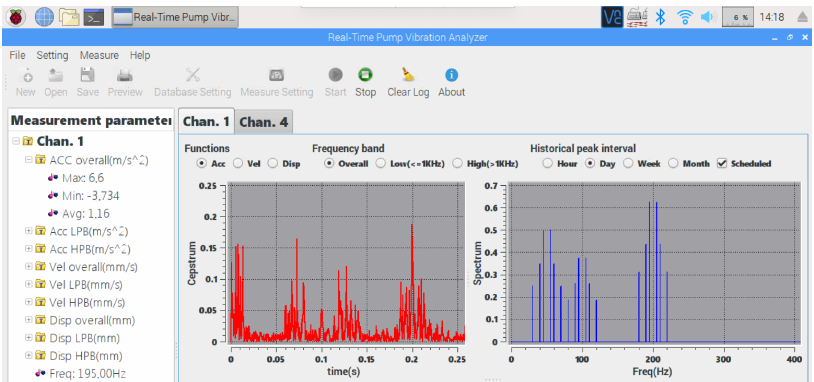
Figure 4. The side bands in simulated gearbox vibration signals by using cepstrum analysis. The left subgraph is the cepstrum computed by (23). The three peaks, at 0.06 s, 0.12 s, and 0.20 s, correspond to frequencies of 17 Hz, 8 Hz, and 5 Hz respectively, which approach the low-frequency components of the modulated signal. These low-frequency components appear as side bands in the right subgraph. Their corresponding frequency values are not identifiable on the spectrogram, but are easily identified on the